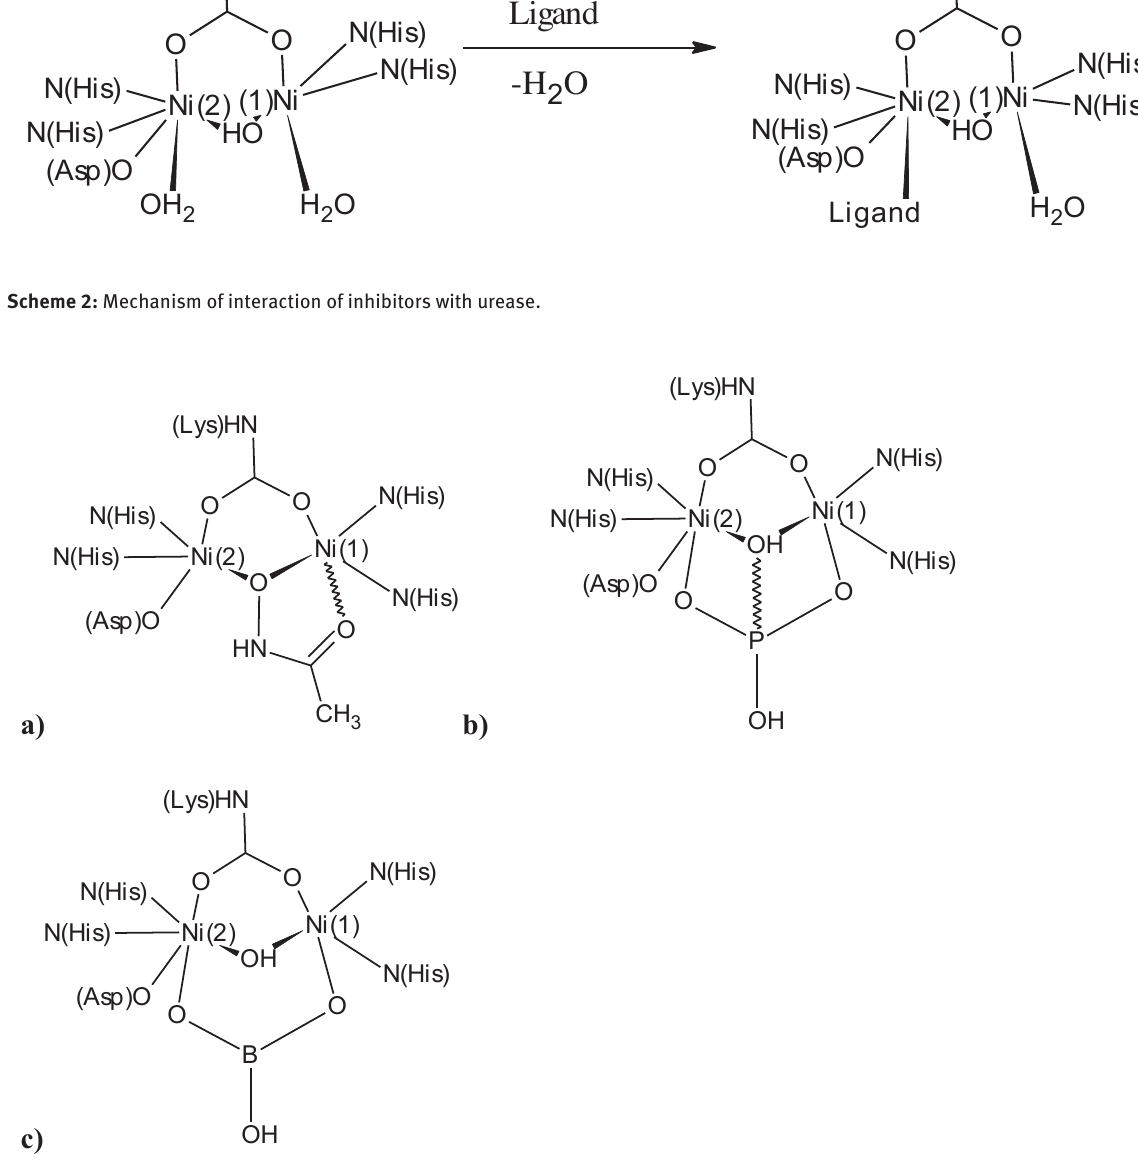
Figure 1: Mechanism of action by different inhibitors (a) by acetohydroxamic acid, (b) by phosphate based molecule, and (c) by boric acid.